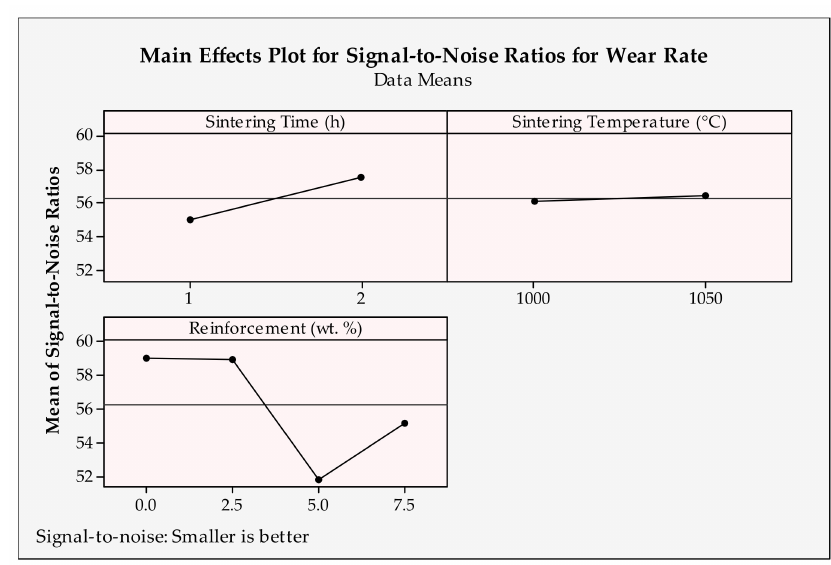
Figure 9. Signal-to-noise ratios of wear rate for production